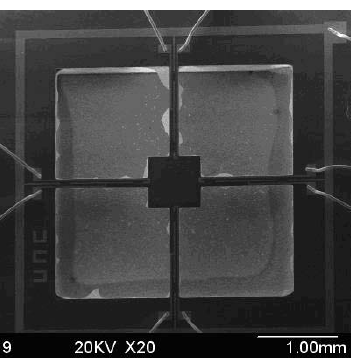
Figure 1. SEM images of the